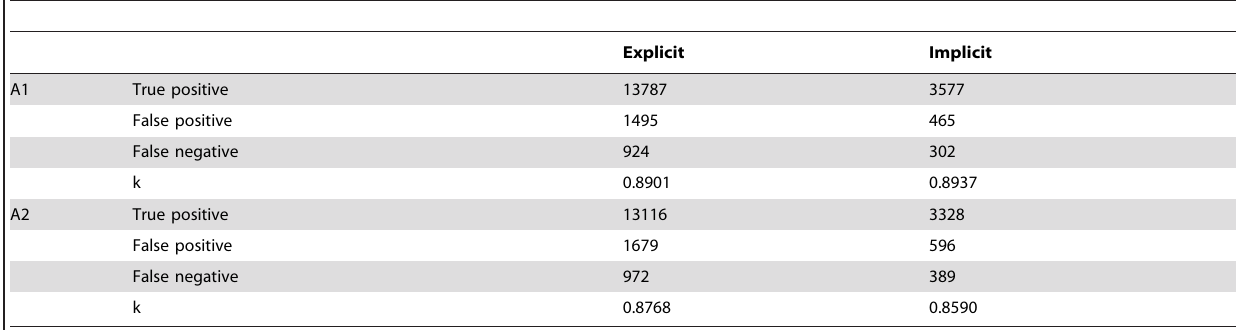
Table 2. Inter-annotator agreement between each annotator and the gold